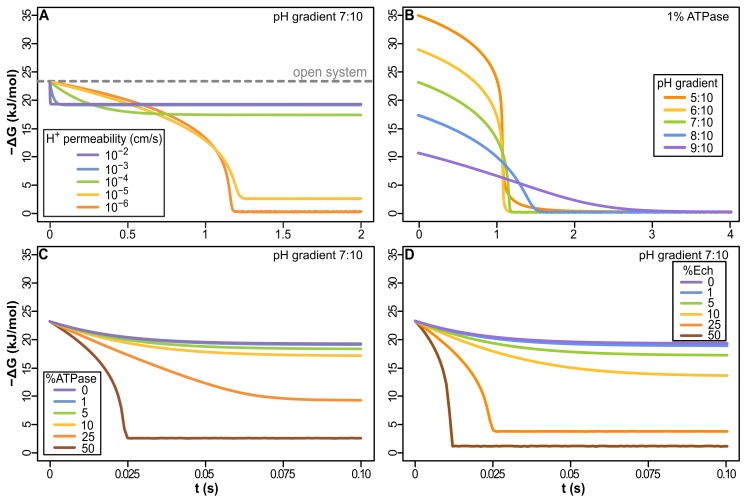
Dynamics of free-energy change (−ΔG) in cells powered by natural proton gradients.(A) Proton-permeable vesicles (≥10−4 cm/s) have only a small loss of free-energy compared with an open system (pH gradient 7∶10, 1% ATPase). Reduced membrane permeability (≤10−4 cm/s), including permeabilities equivalent to modern membranes (<10−5 cm/s), collapse the gradient within seconds. (B) At low permeability (10−6 cm/s), −ΔG collapses regardless of gradient size. Within seconds, H+ flux through ATPase equilibrates with the acidic fluids. (C) The collapse of −ΔG is more extensive the greater the amount of membrane-bound ATPase, even with a leaky membrane (10−3 cm/s). (D) With Ech, the collapse of the natural gradient is similar to that of the ATPase, showing that natural proton gradients can power energy (ATPase) and carbon (Ech) metabolism, given 1%–5% enzyme in membrane. Na+ permeability was kept 6 orders of magnitude higher than that of H+ throughout all simulations in this and all figures of the article. Except in (B), all results were calculated in a pH gradient 7∶10.